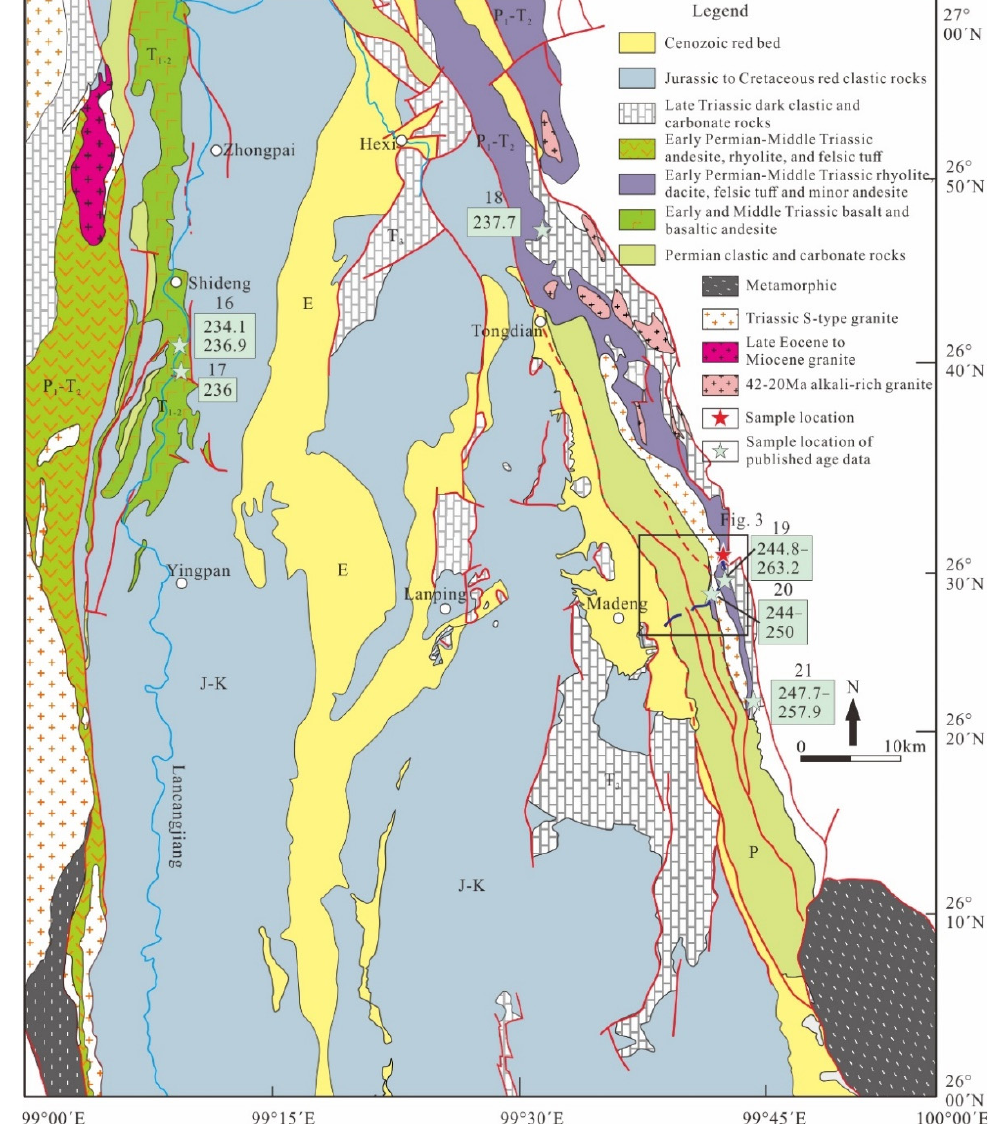
Figure 2. Simplified geological map of the Lanping Basin (modified after [22]), the published data source: [12–15,23].